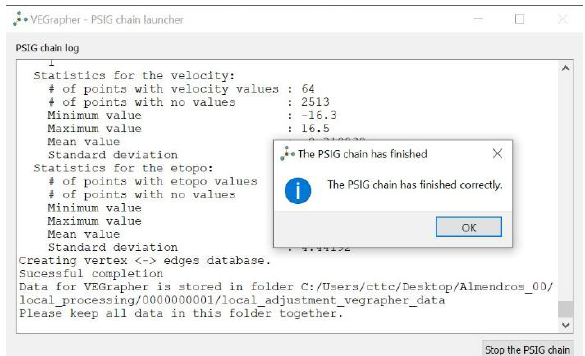
Figure 5: The embedded PSIG software chain log window.